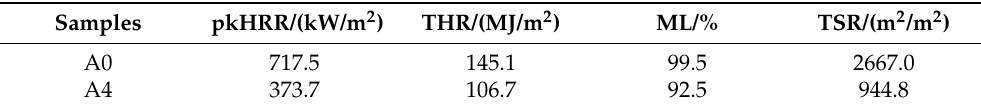
Table 3. The data of cone